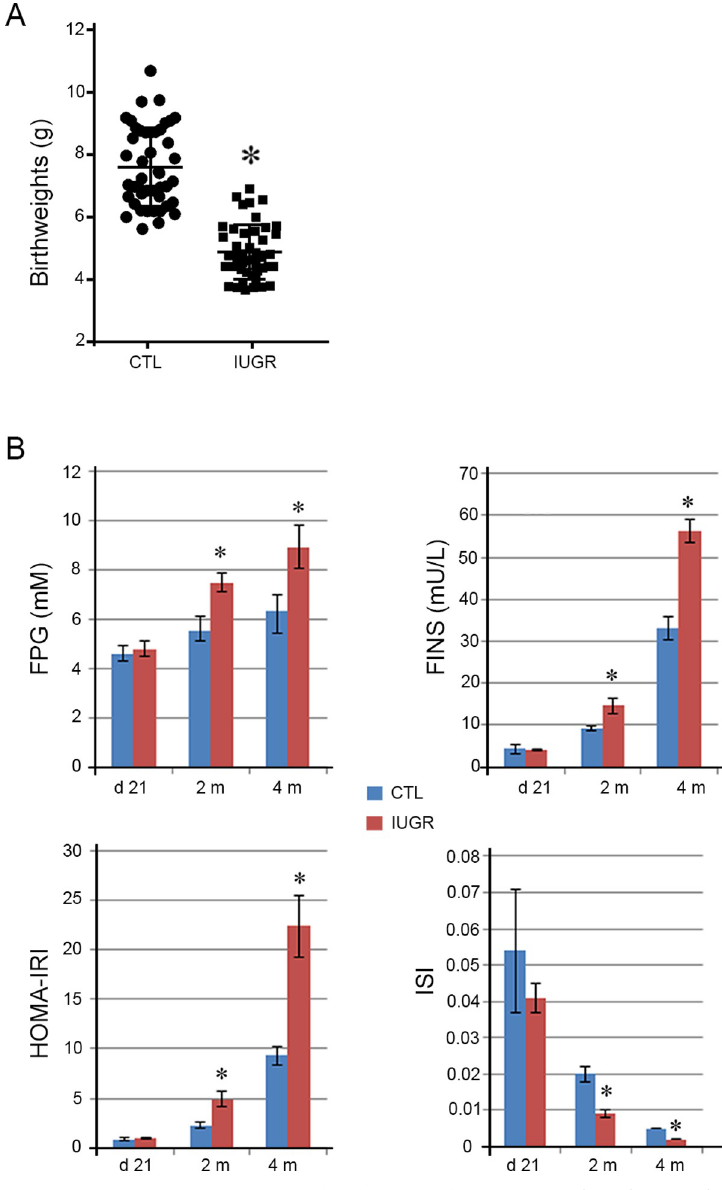
as mean ± SD . n = 45 , � p < 0 . 05 vs . CTL . B. At 21 days, 2 months and 4 months of age, the concentrations of fasting plasma glucose (FPG) and fasting insulin (FINS) were as well as insulin resistance index (HOMA-IRI) and insulin sensitivity index (ISI) were compared between the IUGR offsprings and the controls. At day 21, the four indices did not show differences between the controls and the IUGR offsprings. At 2 and 4 months, the values of FPG, FINS and IRI were significantly higher, whereas the values of the ISI significantly lower in the IUGR offsprings than those in the controls. Data are shown as mean ± SD . n = 15 , � p < 0 . 05 vs . CTL